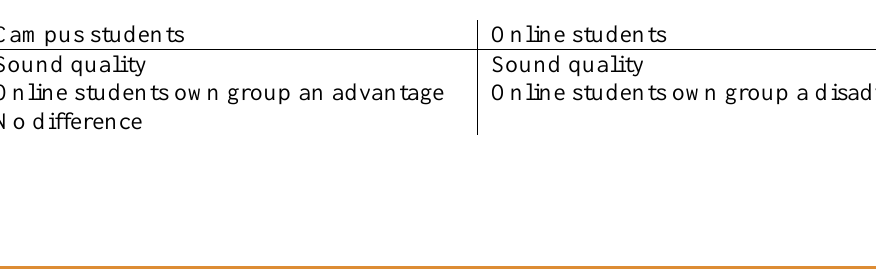
Summary of Students’ Experiences of Laptop Versus Multiple